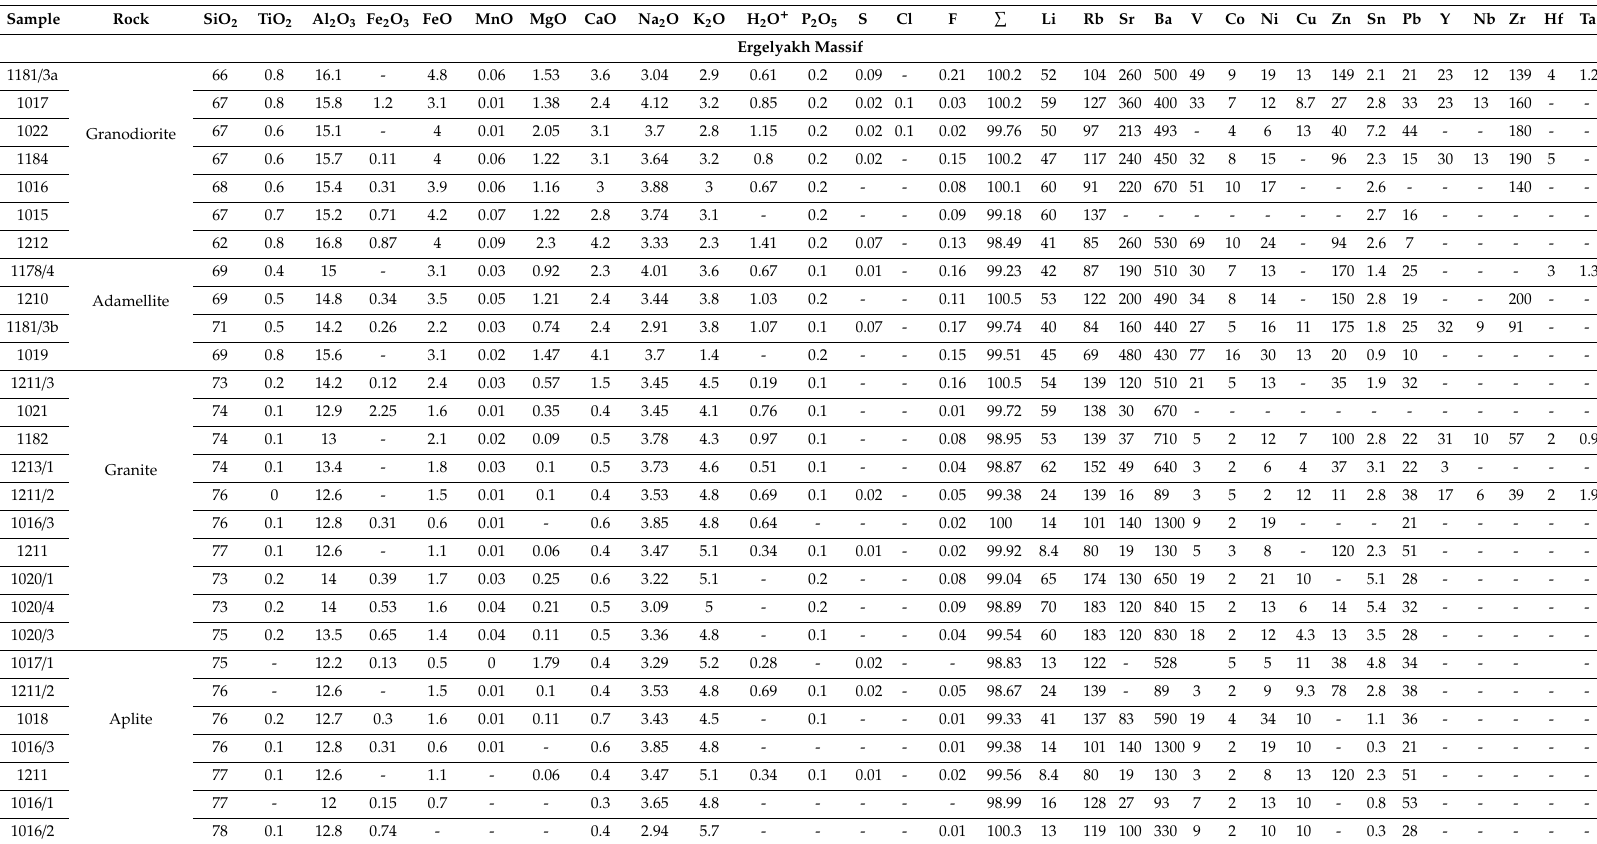
Table 5. Chemical analysis of Ergelyakh and Sokh massif